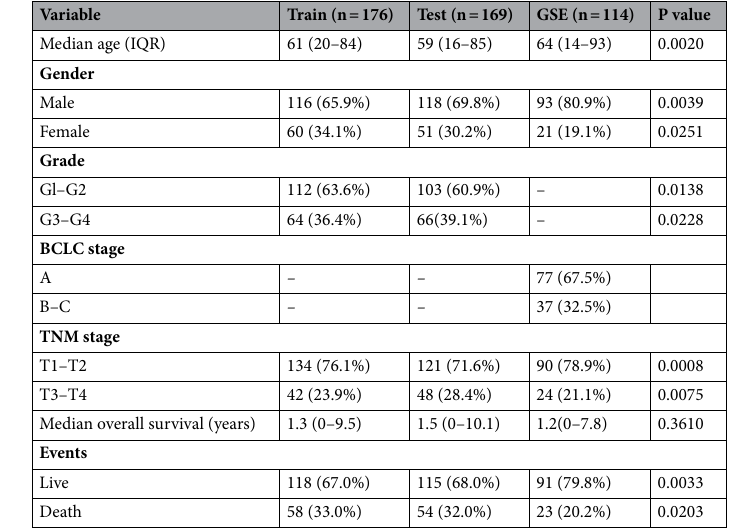
Table 1. The clinical characteristics of patients from TCGA and GEO database.